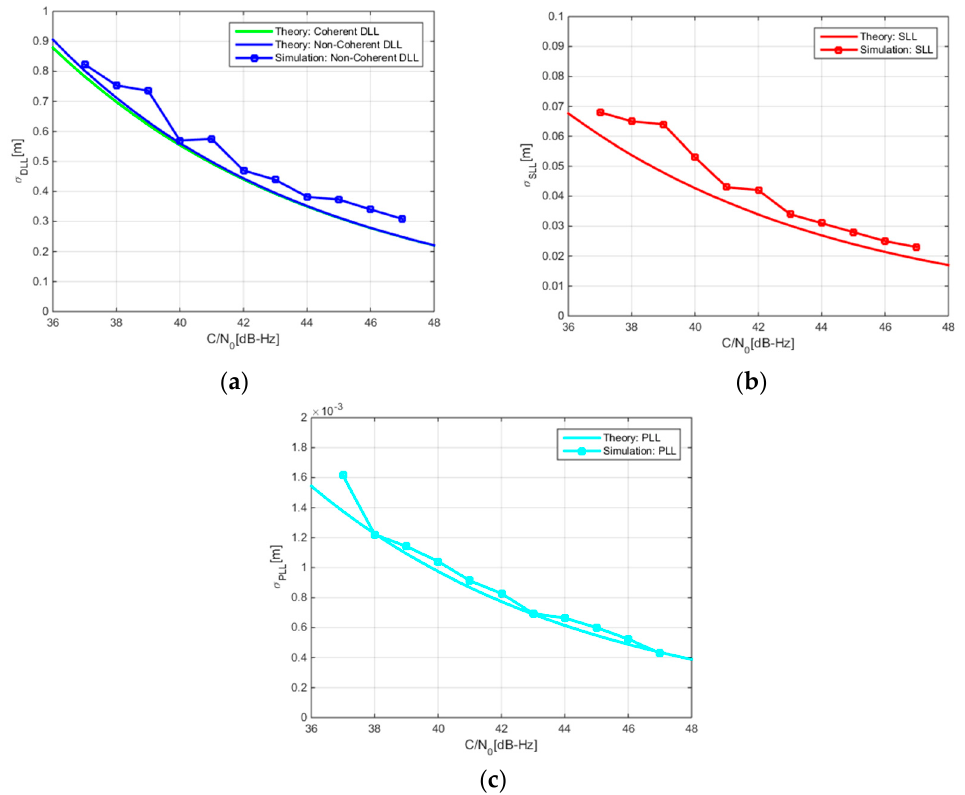
Figure 6. Comparison between the code, subcarrier, and carrier noise errors of B1-ADS. ( a ) Code noise error; ( b ) Subcarrier noise error; ( c ) Carrier noise error.